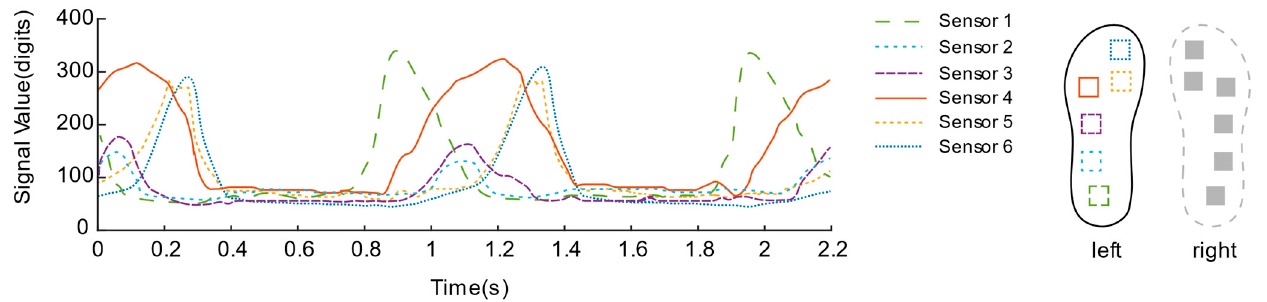
Figure 16. Left foot plantar pressure sensor signal during the bipedal walking experiment.